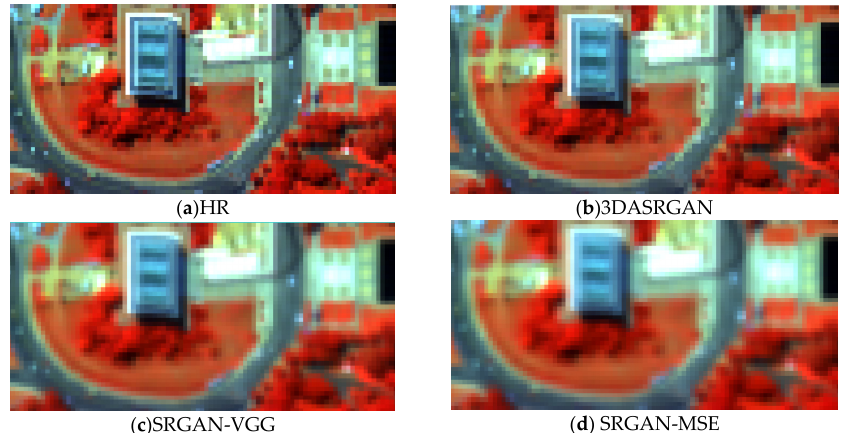
Figure 16. Details of the results of the HR image, 3DASRGAN, SRGAN-VGG, and SRGAN-MSE based on the Washington DC Mall dataset.